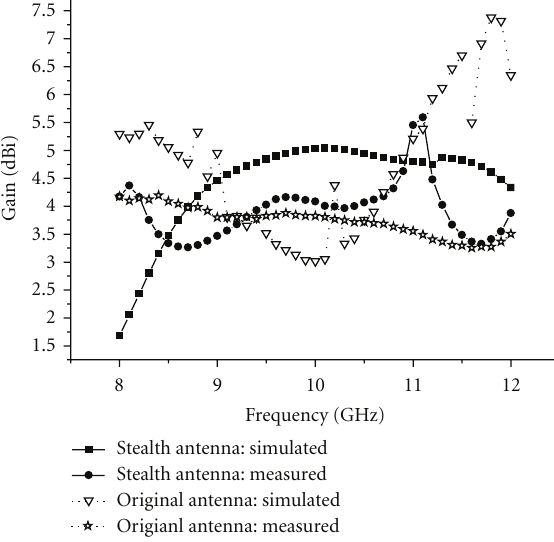
Figure 6: Gain of the